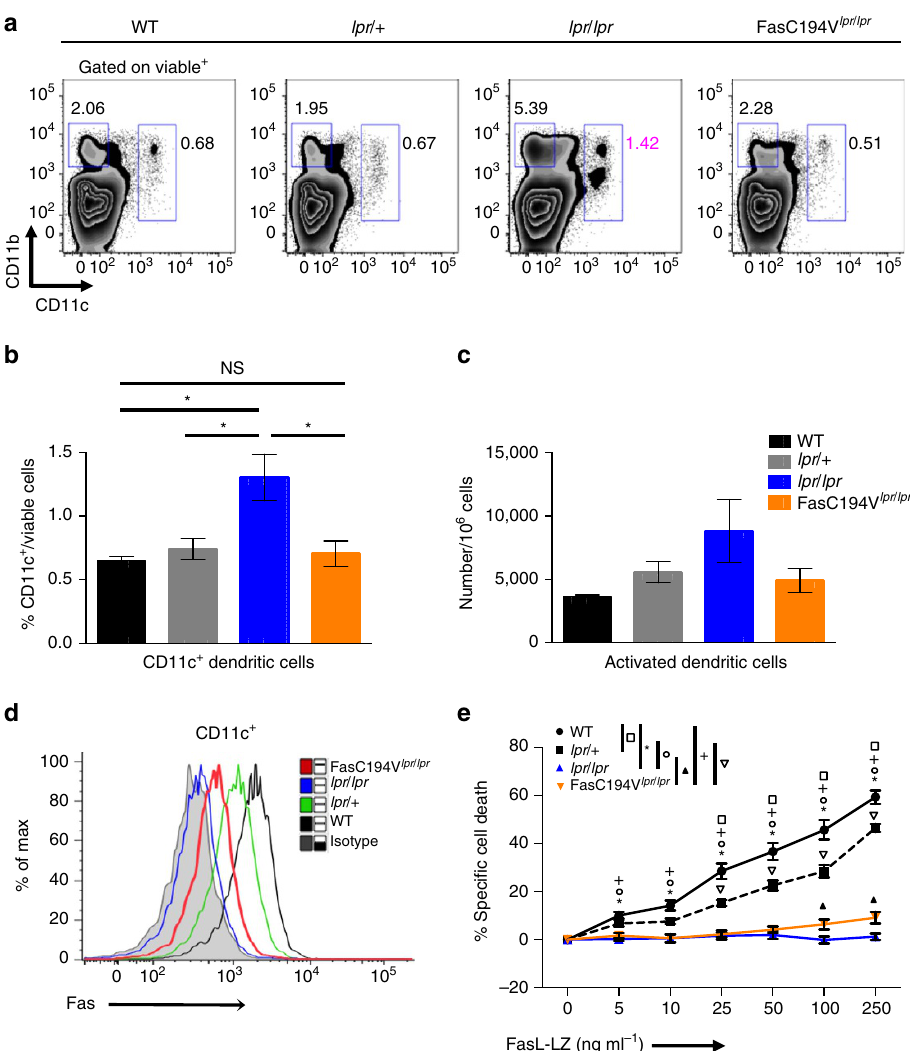
Figure 7 | DC apoptosis requires palmitoylation of Fas. ( a ) Spleens from 24-week-old WT, lpr/ þ , lpr/lpr and FasC194V lpr/lpr mice were isolated and stained for surface markers before analysis by flow cytometry. Data are representative of four independent experiments ( N ¼ 4). Quantitation was performed for CD11c þ DCs ( b ) and CD11c þ CD40 þ CD86 þ MHC-II þ -activated DCs ( c ) in spleens of the indicated genotypes. Mann–Whitney test was used for statistical analysis. * P r 0.05. NS ¼ Not significant. ( d ) DCs were differentiated from bone marrow of mice (BMDC) of the indicated genotypes for 7 days in RPMI supplemented with GM-CSF and stained for surface Fas before flow cytometric analysis. Cultures were Z 85% CD11c þ . Data are representative of three independent experiments ( N ¼ 3). ( e ) In vitro differentiated BMDCs from WT, lpr/ þ , lpr/lpr , or FasC194V lpr/lpr mice were cultured in the presence of increasing amounts of FasL-LZ for 8 h before analysis for apoptosis by flow cytometry. Results are compiled from three independent experiments ( N ¼ 3), with compiled data represented as mean ± s.e.m. * P r 0.001, WT versus lpr/lpr . þ P r 0.001, WT versus FasC194V lpr/lpr . Square: P r 0.001, WT versus lpr / þ . Circle: P r 0.001 lpr / þ versus lpr/lpr . Inverted triangle: P r 0.001, lpr/ þ versus FasC194V lpr/lpr . Filled triangle: P r 0.001 lpr/lpr versus FasC194V lpr/lpr . Unpaired t -test was used for statistical